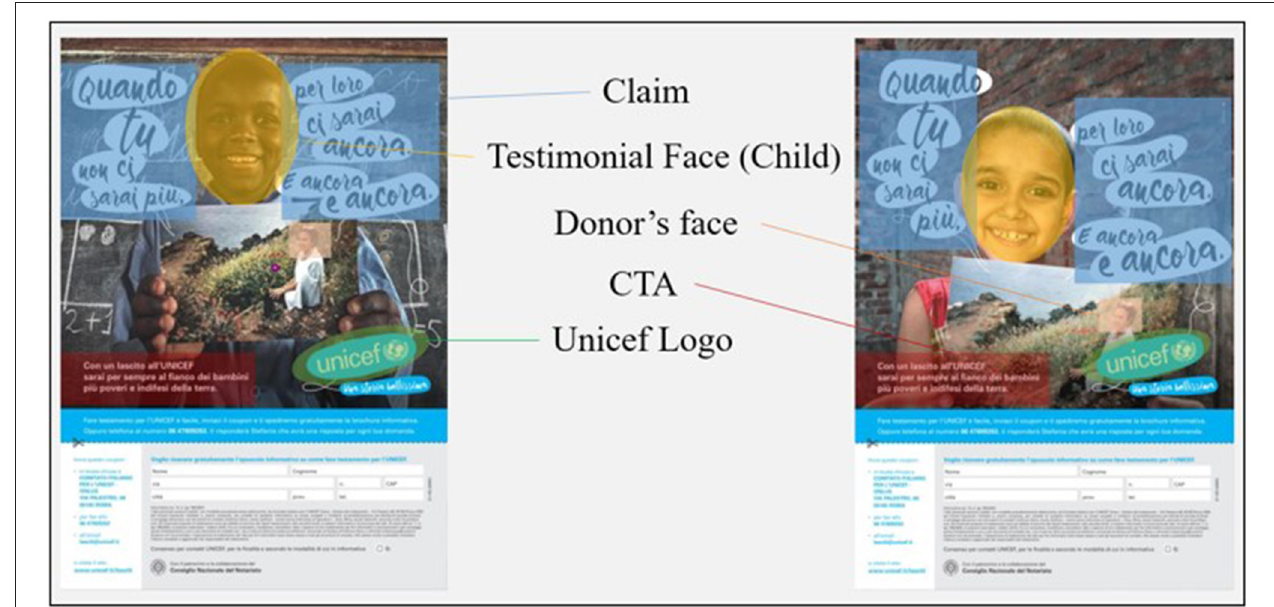
FIGURE 5 | Area of interest on Unicef